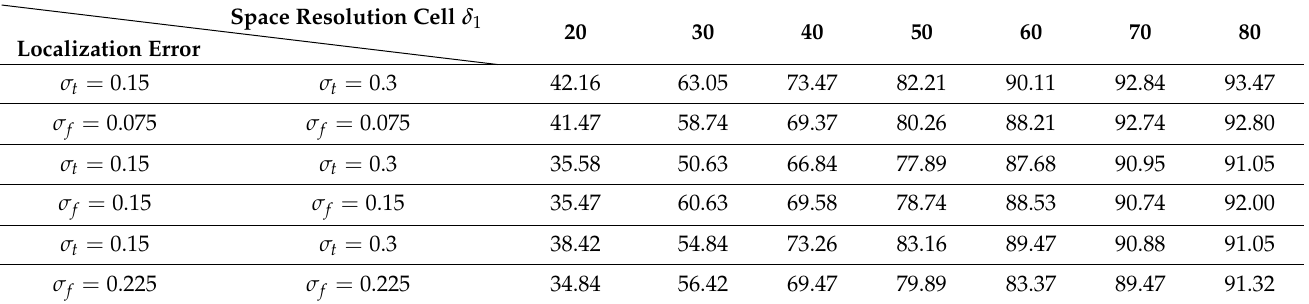
Table 6. The pass ratio of same source testing under different radar resolution and different localiza- tion error (unit of pass ratio: